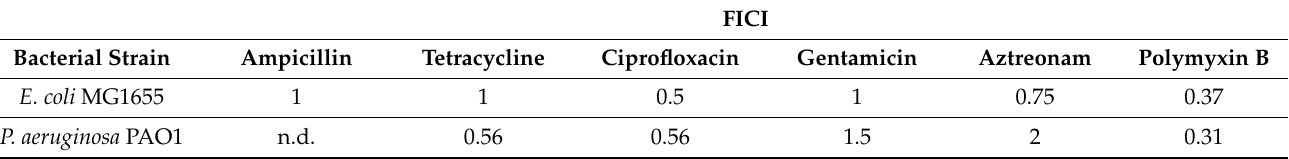
Table 2. Fractional inhibitory concentration index (FICI) for antibiotics paired with LL-37 against E. coli and P. aeruginosa lab strains.